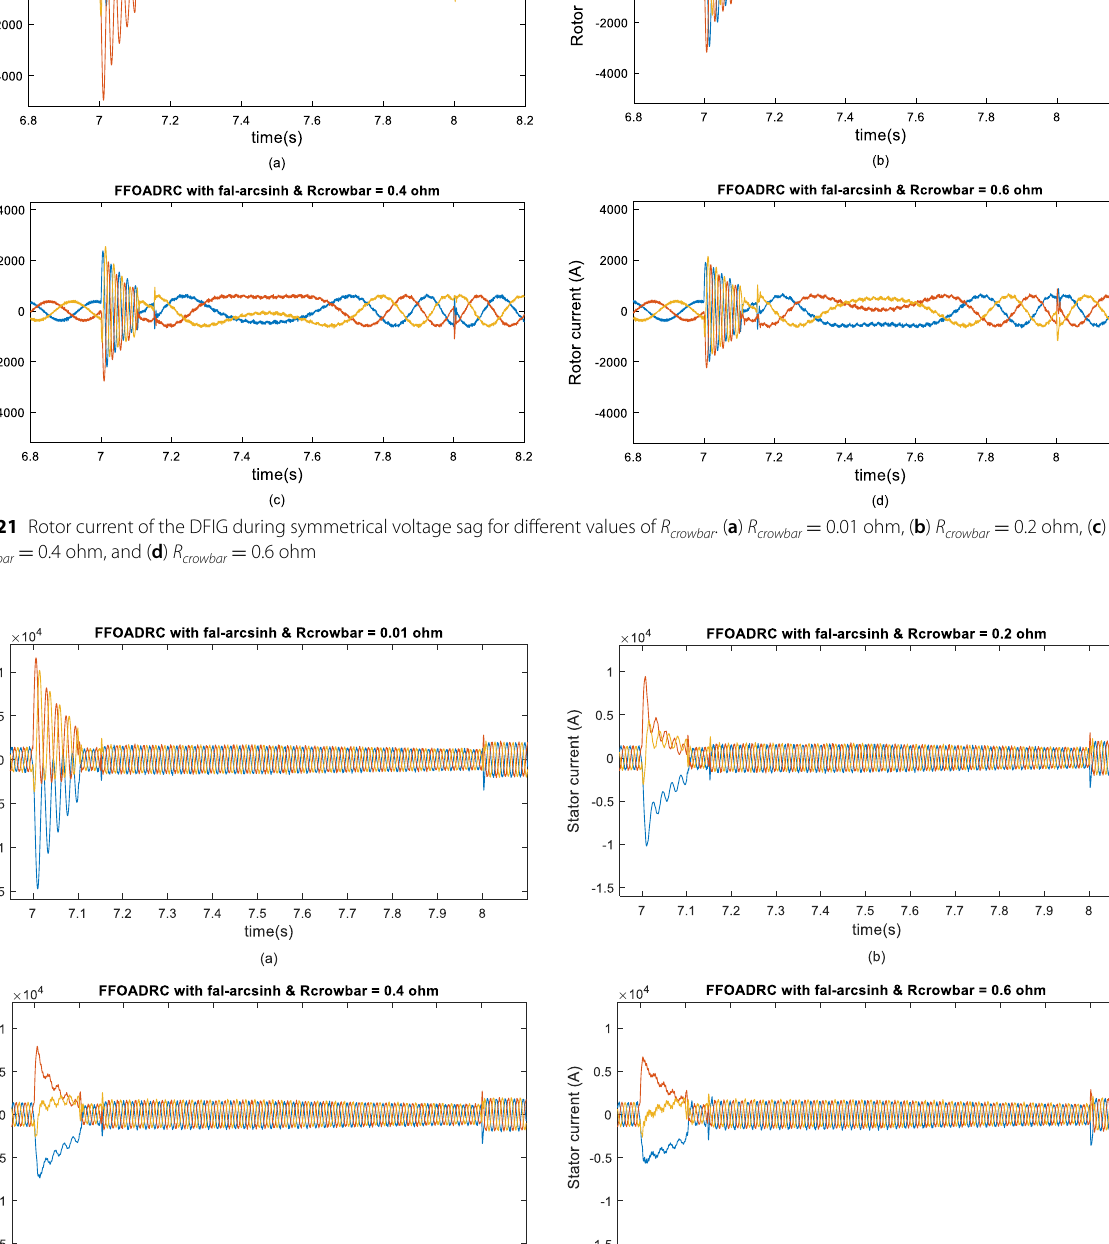
0.01 ohm, ( b ) R crowbar =